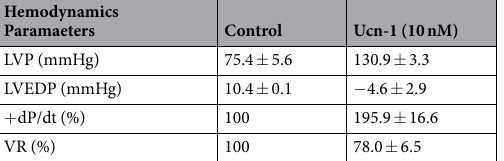
Table 1. Summary data of changes in hemodynamics parameters produced by 10 nM Ucn-1 in Langendorff- perfused hearts. Left ventricular pressure (LVP), left ventricular end diastolic pressure (LVEDP), maximum derivative of left ventricular pressure ( + dP/dt), and vascular resistance (VR) were evaluated 20 minutes after Ucn-1 addition in 6